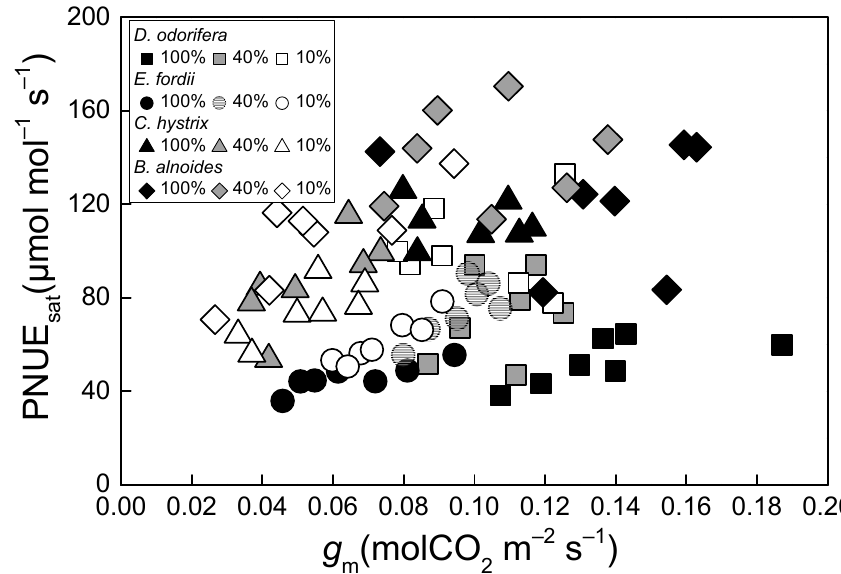
Figure 2. Relationship between PPFD-saturated photosynthetic N use efficiency (PNUE sat ) and mesophyll conductance ( g m ) in Dalbergia odorifera , Erythrophleum fordii, Betula alnoides , and Castanopsis hystrix grown under three different irradiance treatments.